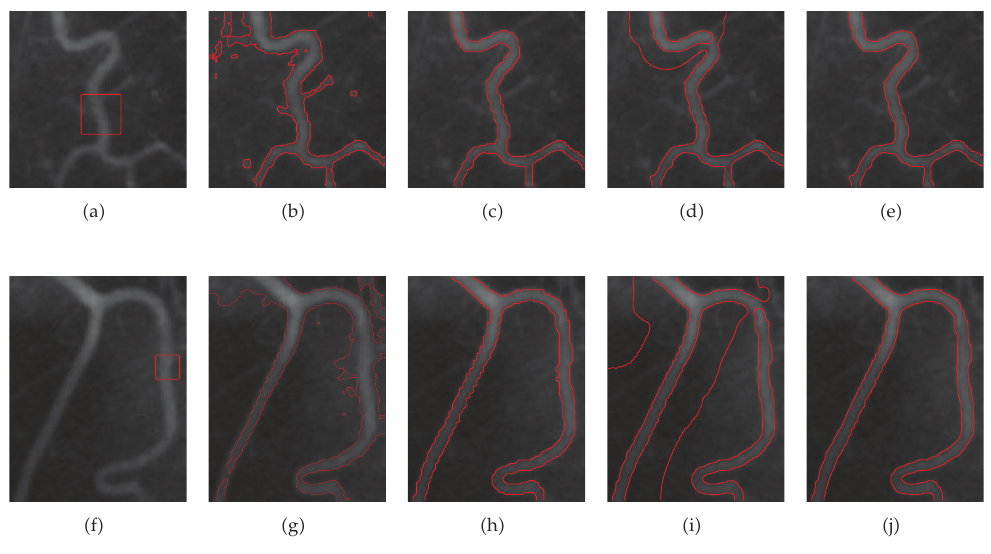
Figure 4: Results of two vessel images with di ff erent methods. (cid:6) a (cid:7) and (cid:6) f (cid:7) Original images with initial contours. (cid:6) b (cid:7) and (cid:6) g (cid:7) Final contours with the CV model. (cid:6) c (cid:7) and (cid:6) h (cid:7) Final contours with the LBF model. (cid:6) d (cid:7) and (cid:6) i (cid:7) Final contours with the LGIF model. (cid:6) e (cid:7) and (cid:6) j (cid:7) Final contours with the proposed model.